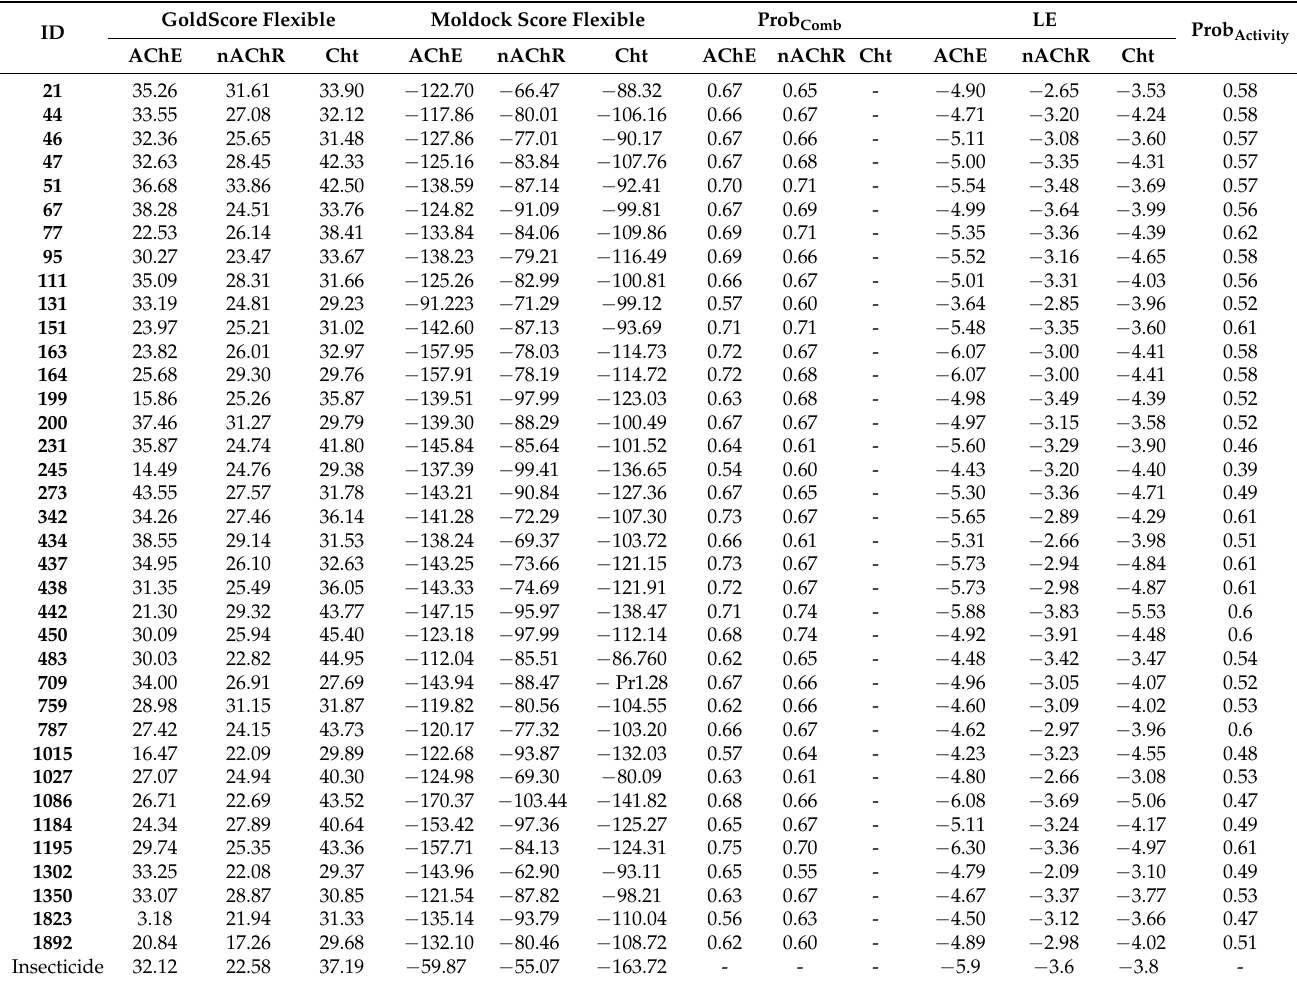
Table 5. Moldock Score and GoldScore values obtained from docking and combined probability values (Prob Comb ) between prediction models and molecular coupling analysis for potential activity against D. melanogaster . In the table, only the Prob Comb values considered active are presented. Data on the ligand efficiency (LE) of the compounds are also available in the